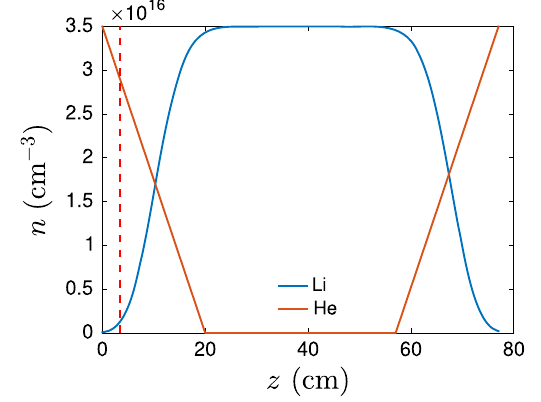
FIG. 7. Helium and lithium gas density profile. The red dashed line is the position of the witness beam ’ s focal plane: z ¼ 3 . 39 cm.